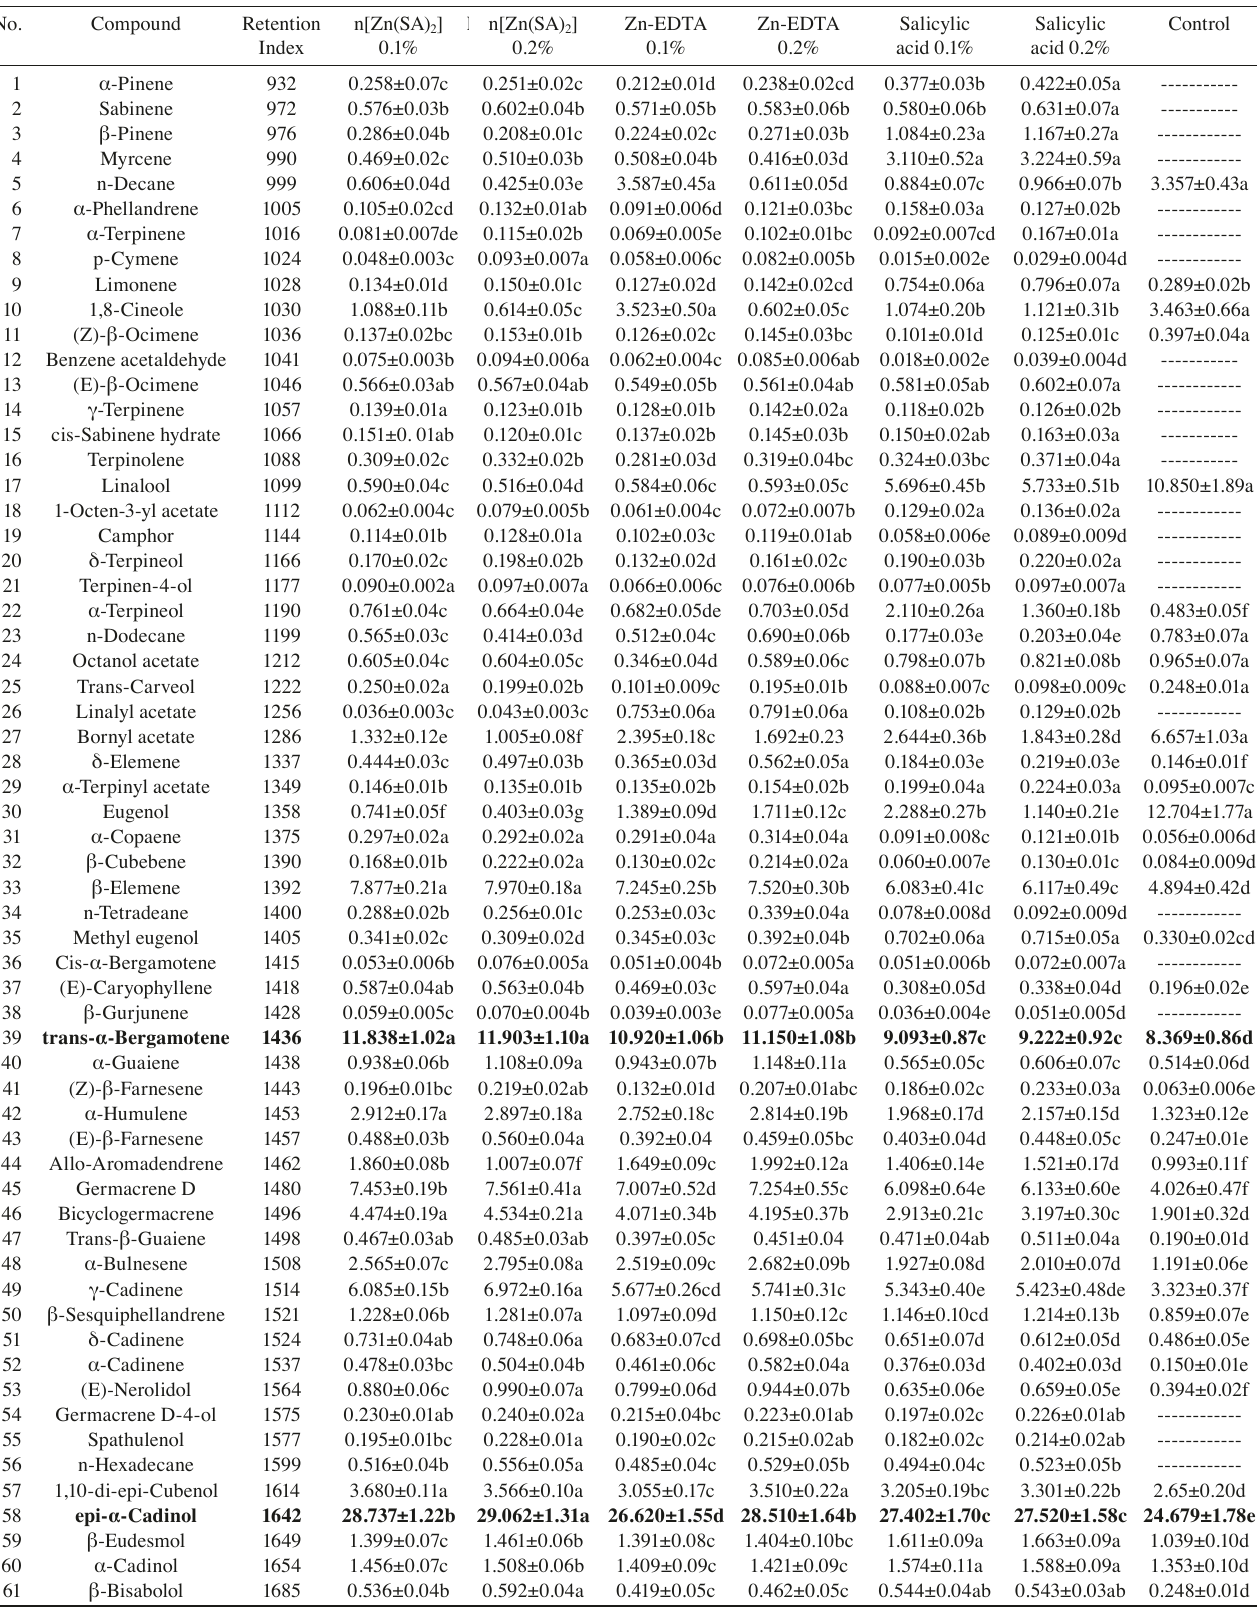
Data are mean ±standard deviation of eight replications . Means followed by the same letter within a row are not significantly different according to Duncan’s multiple range test at P< 0.05.